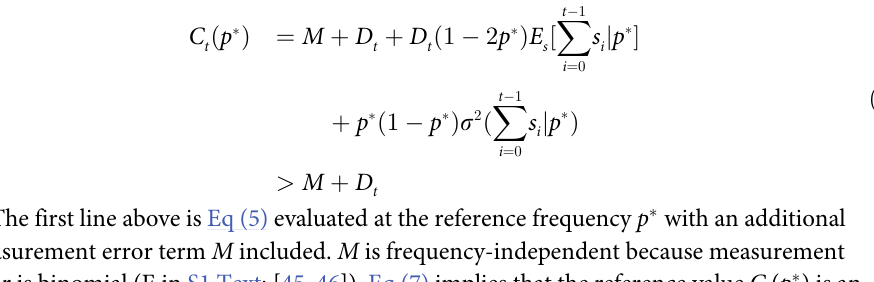
S1 Fig. Frequency dependence of C . Same as Fig 3 but for the Bergland et al. data. Each curve represents a different seasonal iterate e.g. summer 2009 to fall